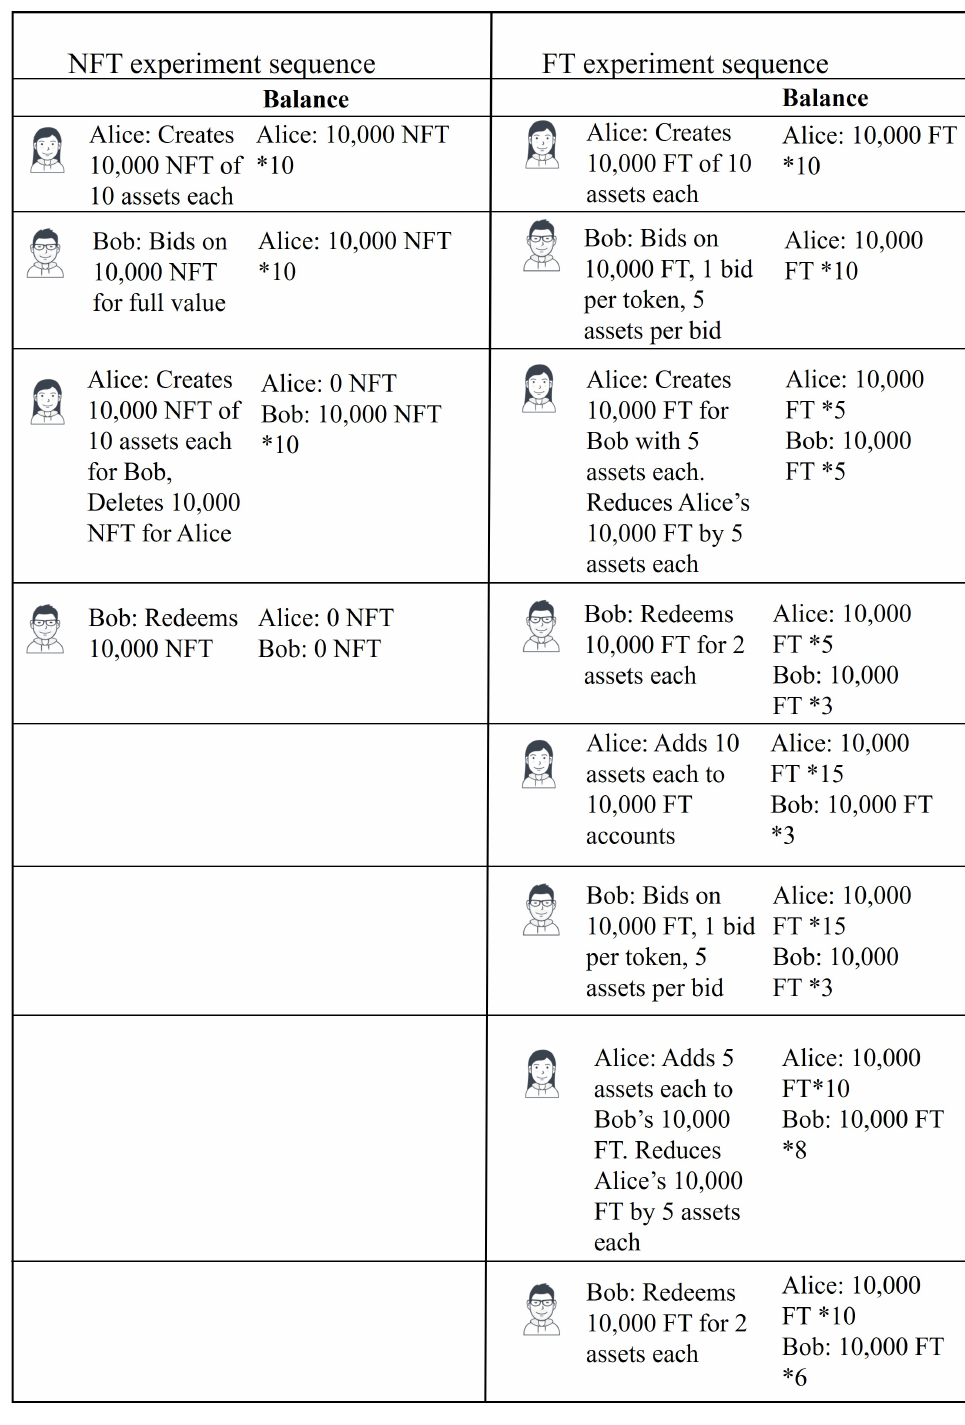
Figure 5. Sequence of